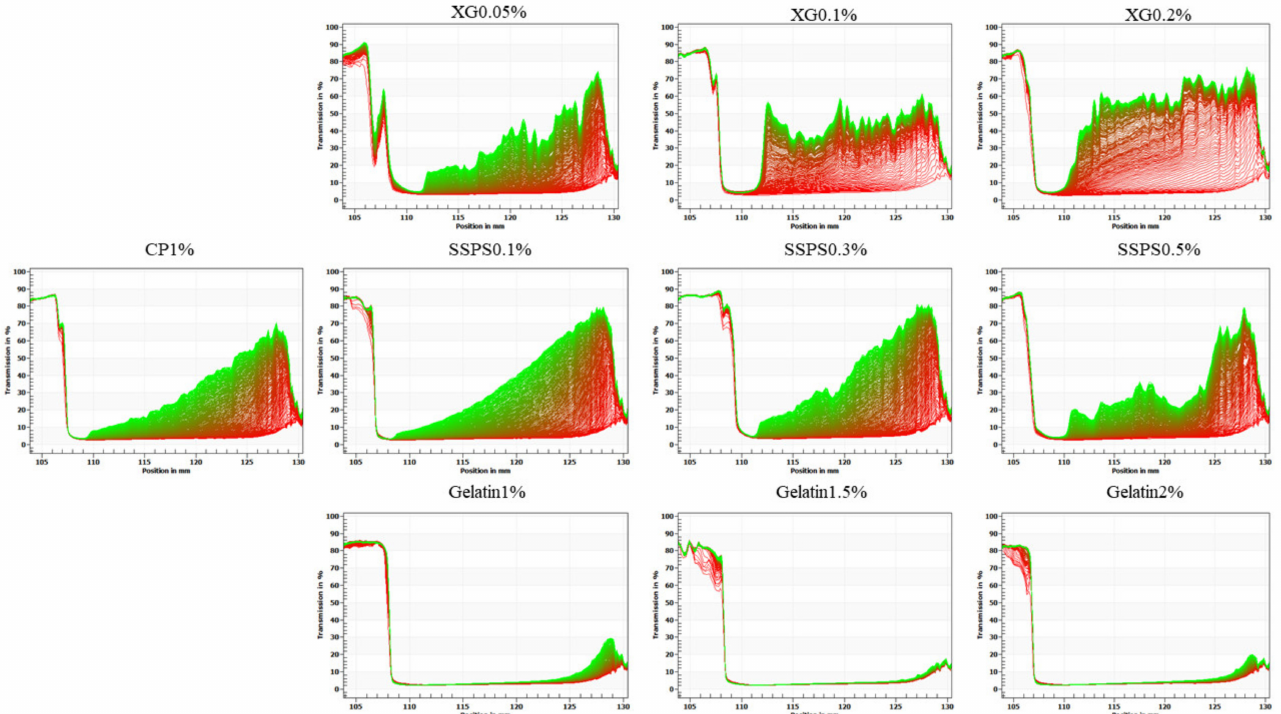
Figure 9. Evolution of transmission profiles of emulsion samples at different concentrations (CP concentration, 1%). All transmission profiles were measured using the LUMiSizer. ( left : start, red line; right : end, green line) (CP-Coconut protein, XG-Xanthan gum, SSPS-Soluble soybean